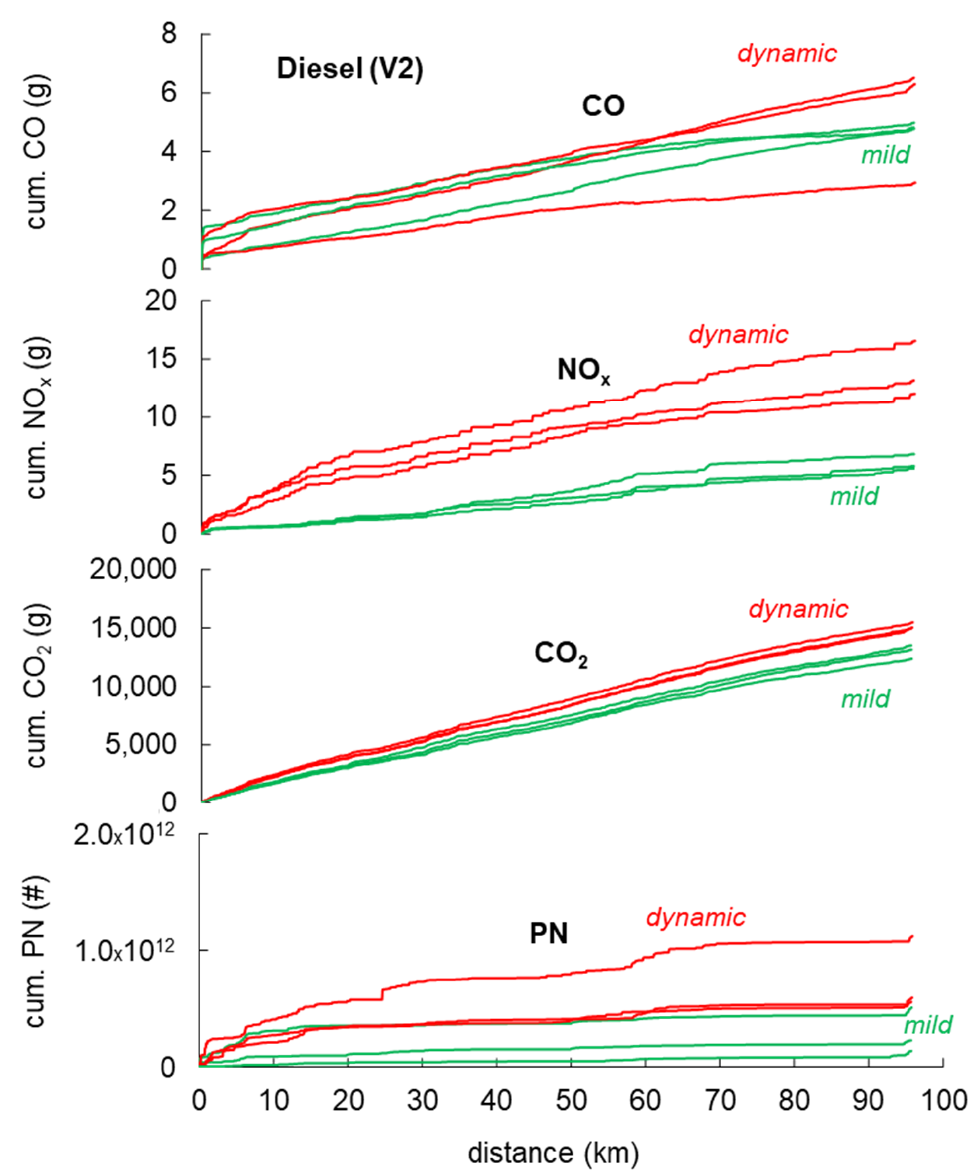
Figure 8. Influences of the driving style on the cumulated emissions of the diesel vehicle (V2). A rough comparison of emissions of both test vehicles (V1 gasoline Euro 5 and V2 Diesel Euro 6) shows the same typical proportions: higher CO, higher CO 2 , and higher PN ( w / o GPF) values for gasoline V1; higher NO x and lower PN (with DPF) for diesel V2. Figure 9 summarizes the variations of the emissions in (%) between mild and dynamic driving style. The higher variations of NO x and CO 2 in the urban part can be generalized as an effect of higher dynamics in city driving. The very high variations of CO of the gasoline car (especially in the rural- and highway parts) must be considered as specific for (CO) of this vehicle. The PN-emissions of the diesel vehicle are at a very low level (due to DPF) and the driving style has a stronger percentual influence than with the gasoline vehicle (GDI w / o